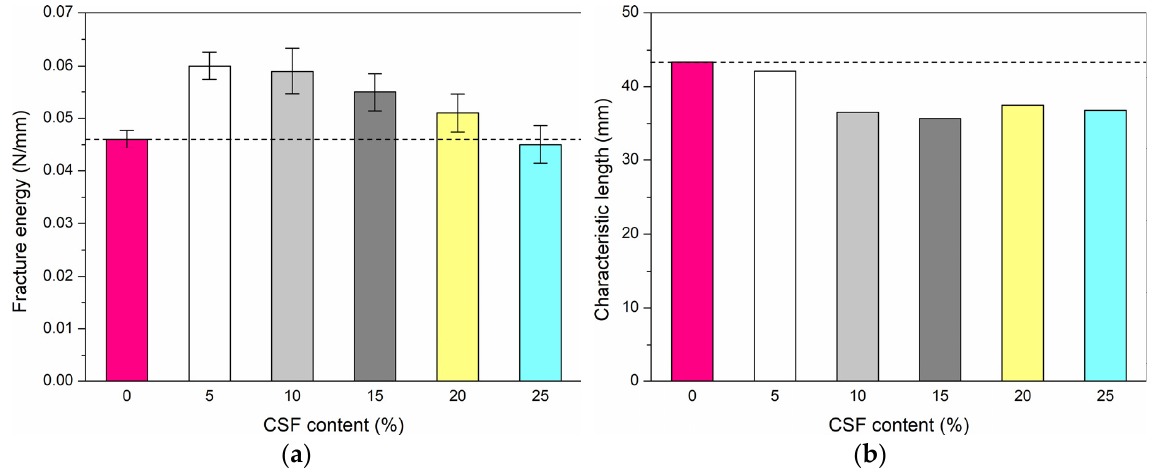
Figure 9. Differences in ( a ) fracture energy; ( b ) characteristic length with CSF content.